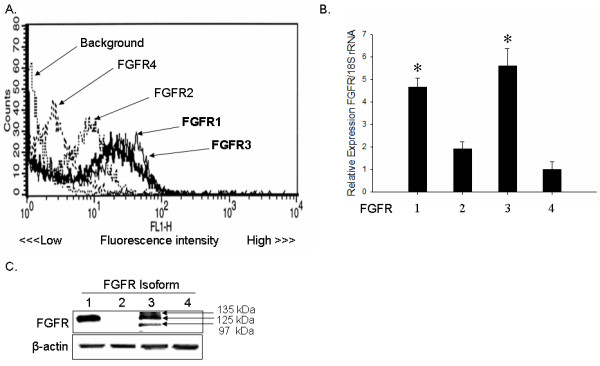
Abundant FGFR1 and FGFR3 expression in articular chondrocytes. (A) Human articular chondrocytes were incubated with anti-CD32/CD16 monoclonal antibody to block nonspecific antibody binding. FGFR1, FGFR2, FGFR3, and FGFR4 antibodies were incubated with cells, followed by incubation with a secondary antibody, goat-anti-rabbit Alexa Fluor 488. Cells were also incubated with goat-anti-rabbit Alexa 488, or non-immune rabbit serum plus goat-anti-rabbit Alexa Fluor 488 as controls. FGFRs on the plasma membrane of chondrocytes were analyzed with a FACS Calibur instrument and CellQuest software. (B) Human articular chondrocytes in monolayer were subjected to RNA extraction, cDNA synthesis, and qPCR quantification of FGFR isoform expression. * P < 0.05. (C) Human articular chondrocytes in monolayer were directly lysed. Equal amounts of total protein were resolved on a SDS-PAGE gel, followed by transfer and immunoblotting of FGFR isoforms. FGF, fibroblast growth factor; FGFR, FGF receptor; qPCR, quantative polymerase chain reaction.